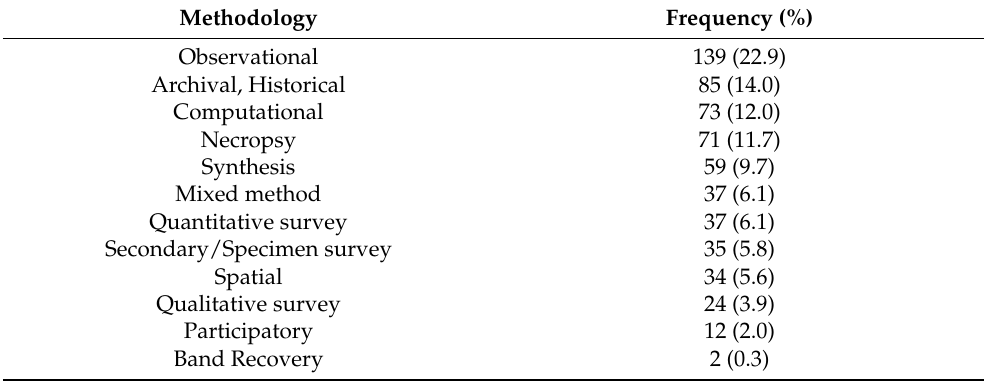
Table 4. Methodology used within the reviewed human-raptor interaction research.